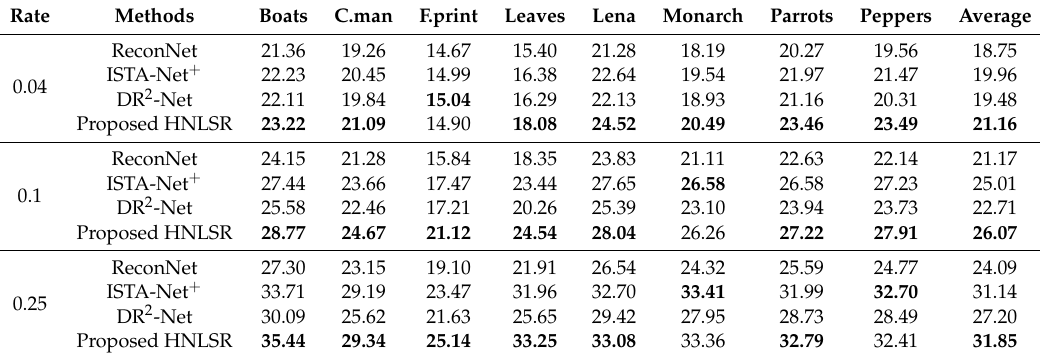
Table 3. PSNR (dB) comparison of deep learning methods and the proposed method.